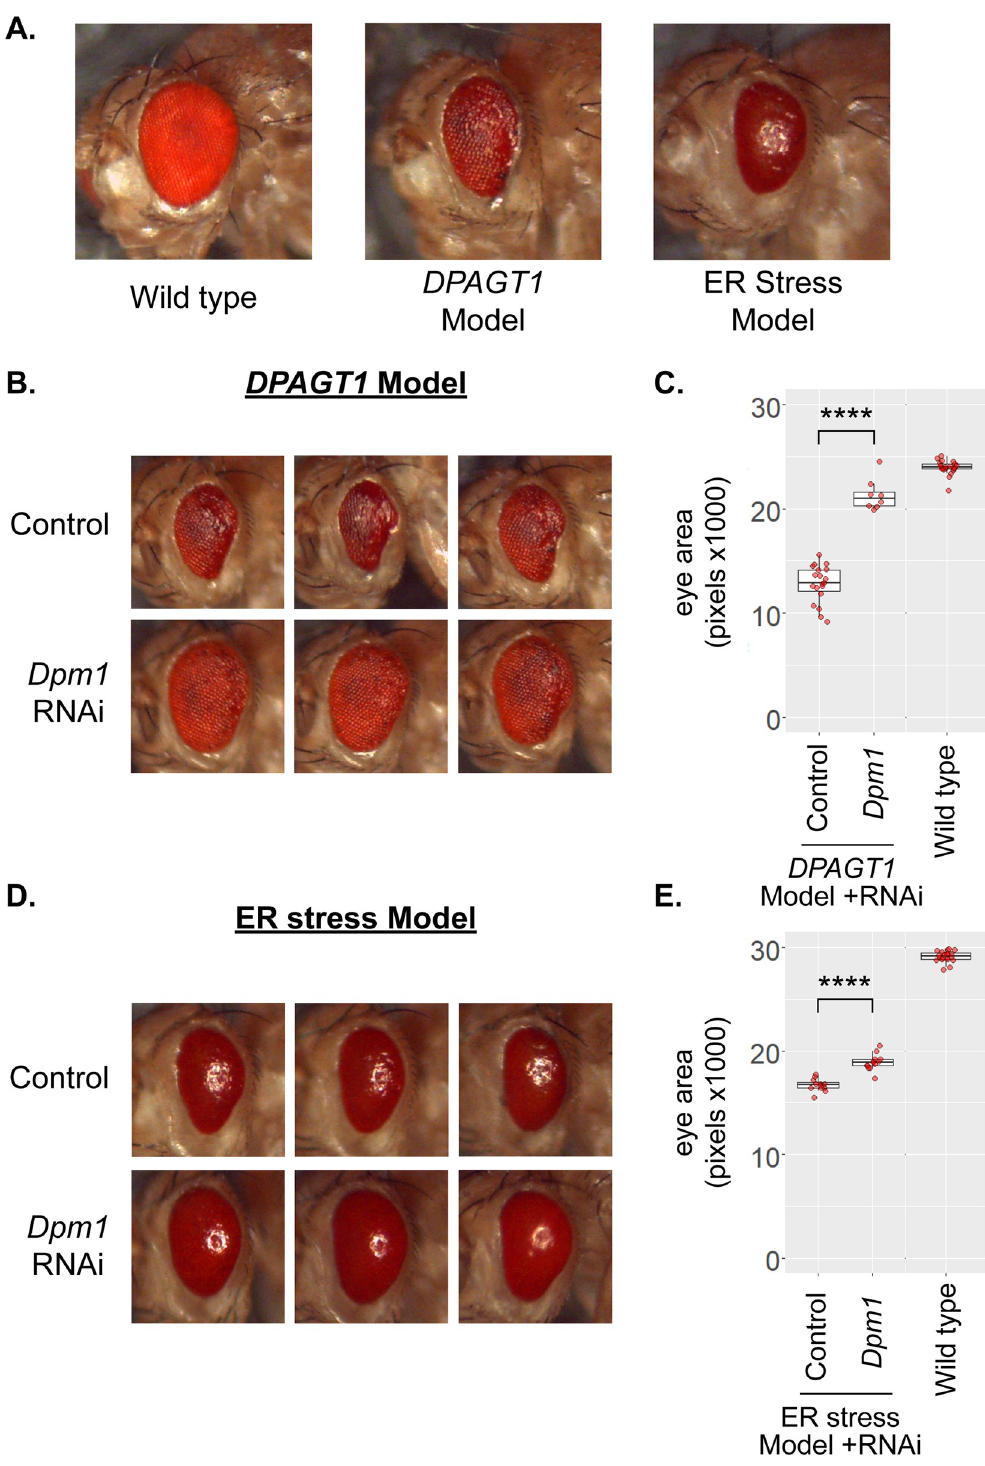
Fig 3. Knockdown of the mannosyltransferase DPM1 rescues the DPAGT1 and ER stress models. (A) We generated a DPAGT1 model that drives RNAi against DPAGT1 in the fly eye (middle). This causes a small, rough eye phenotype. In addition to the DPAGT1 model, we also used an ER stress fly model that overexpresses the misfolded protein Rh1 G69D in the eye (right). (B) RNAi against the mannosyltransferase Dpm1 strongly rescues the DPAGT1 model. The three images are representative from the same experimental cross and RNAi line (BDSC 51396) or control RNAi background (attP2,